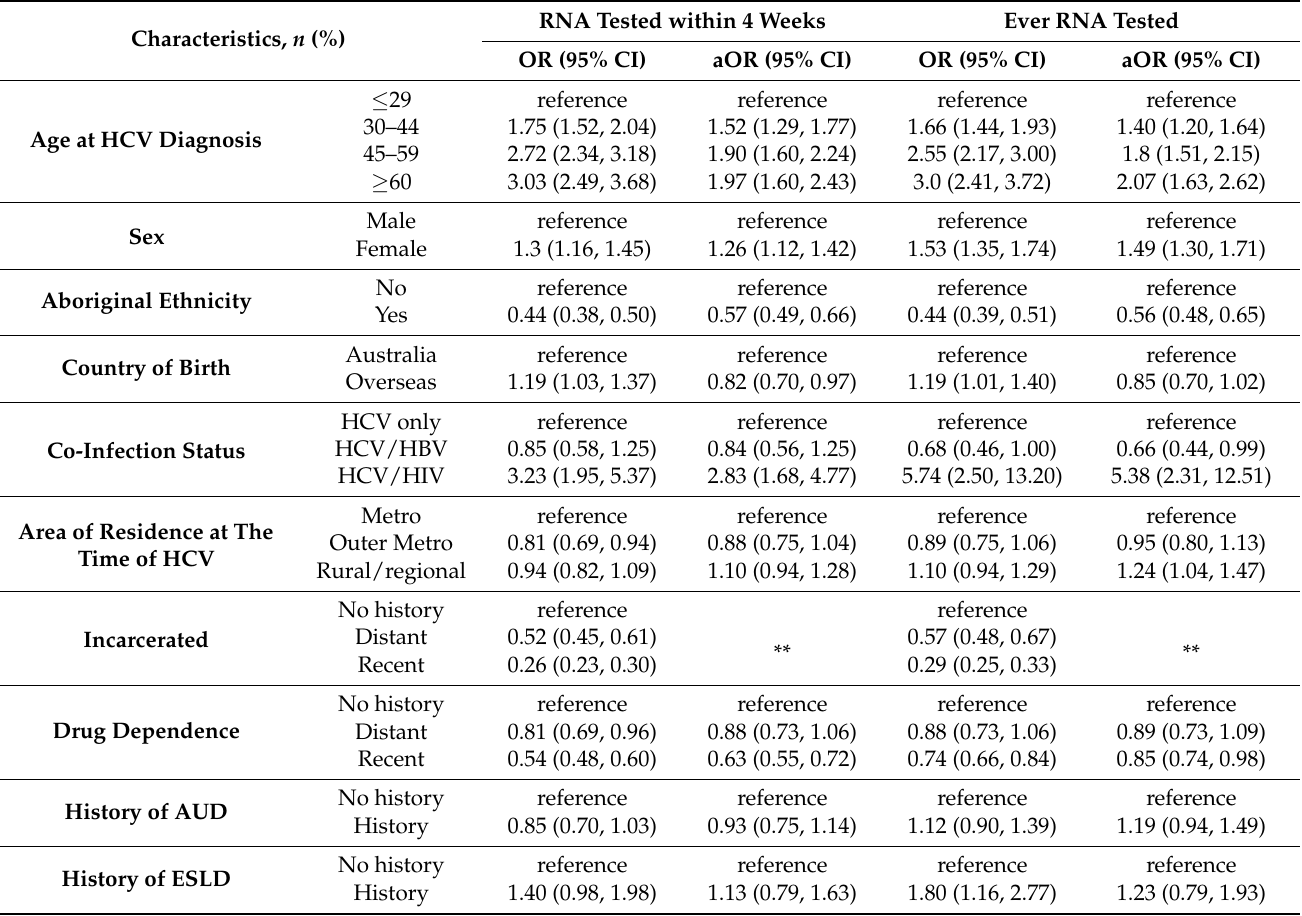
Table 3. Univariate and multivariate logistic regression analysis showing the predictors of timely (within 4 weeks of HCV notification) and ever RNA tested among people with an HCV notification in NSW 2016–2018 (N =